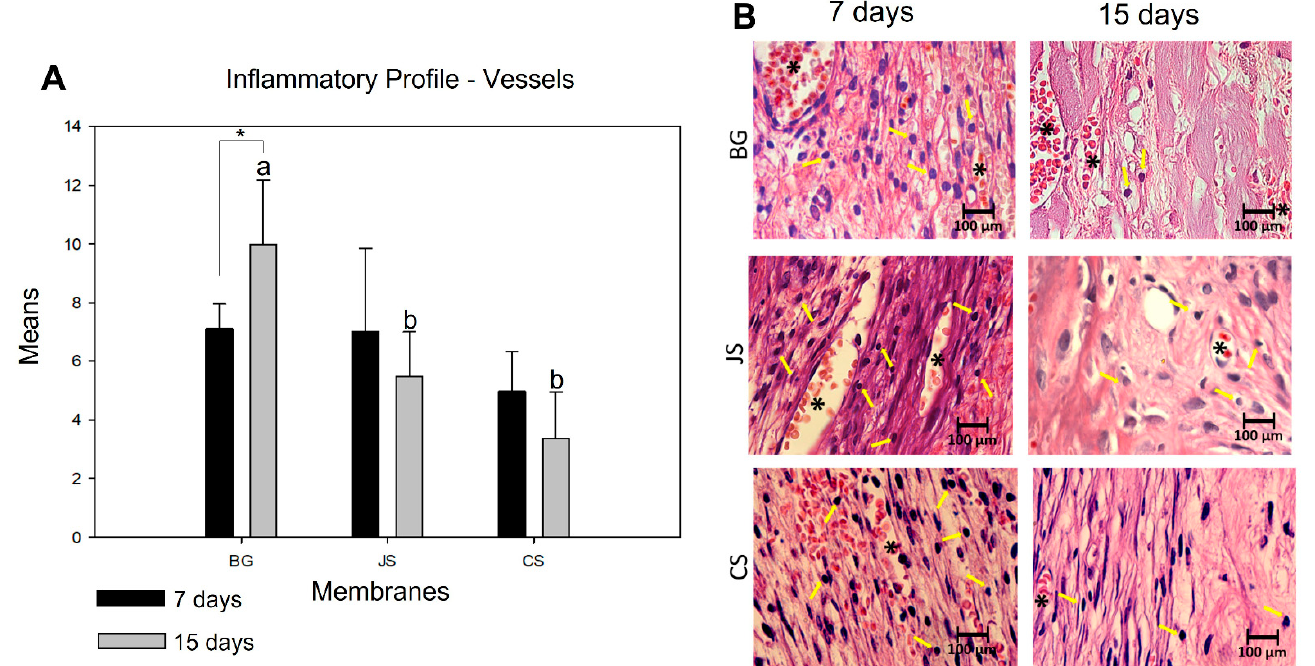
Figure 5. ( A ) Graph showing the comparisons of the means and standard deviations within and between groups to analyze the number of blood vessels at seven and 15 days. The lowercase letters show a statistically significant difference at 15 days. There was no statistical difference for the seven- day period. The * demonstrates whether there was a statistically significant difference within the group at seven and 15 days. ( B ) In the photomicrographs on the side taken at 100× magnification, the yellow arrows indicate the cells (lymphocytes) and the * blood vessels.